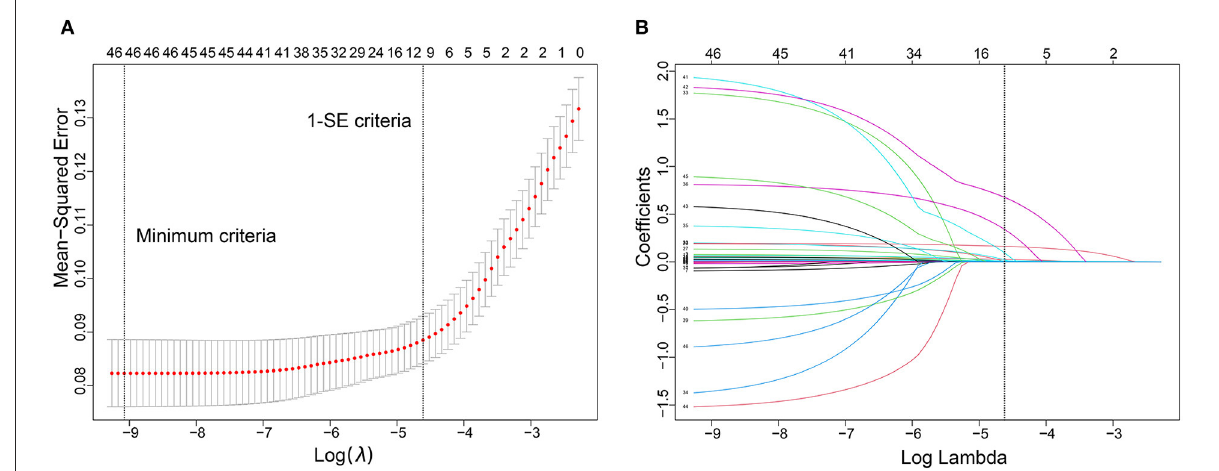
FIGURE2 Predictor selection using the least absolute shrinkage and selection operator (LASSO) logistic regression model. (A) Identification of the optimal penalization coefficient lambda ( λ ) in the LASSO model. The dotted vertical line was plotted at the value selected using 10-fold cross-validation, for which the optimal λ resulted in 10 non-zero coefficients. (B) LASSO coefficient profiles of the 45 predictors. A coefficient profile plot was produced against the log ( λ ) sequence.